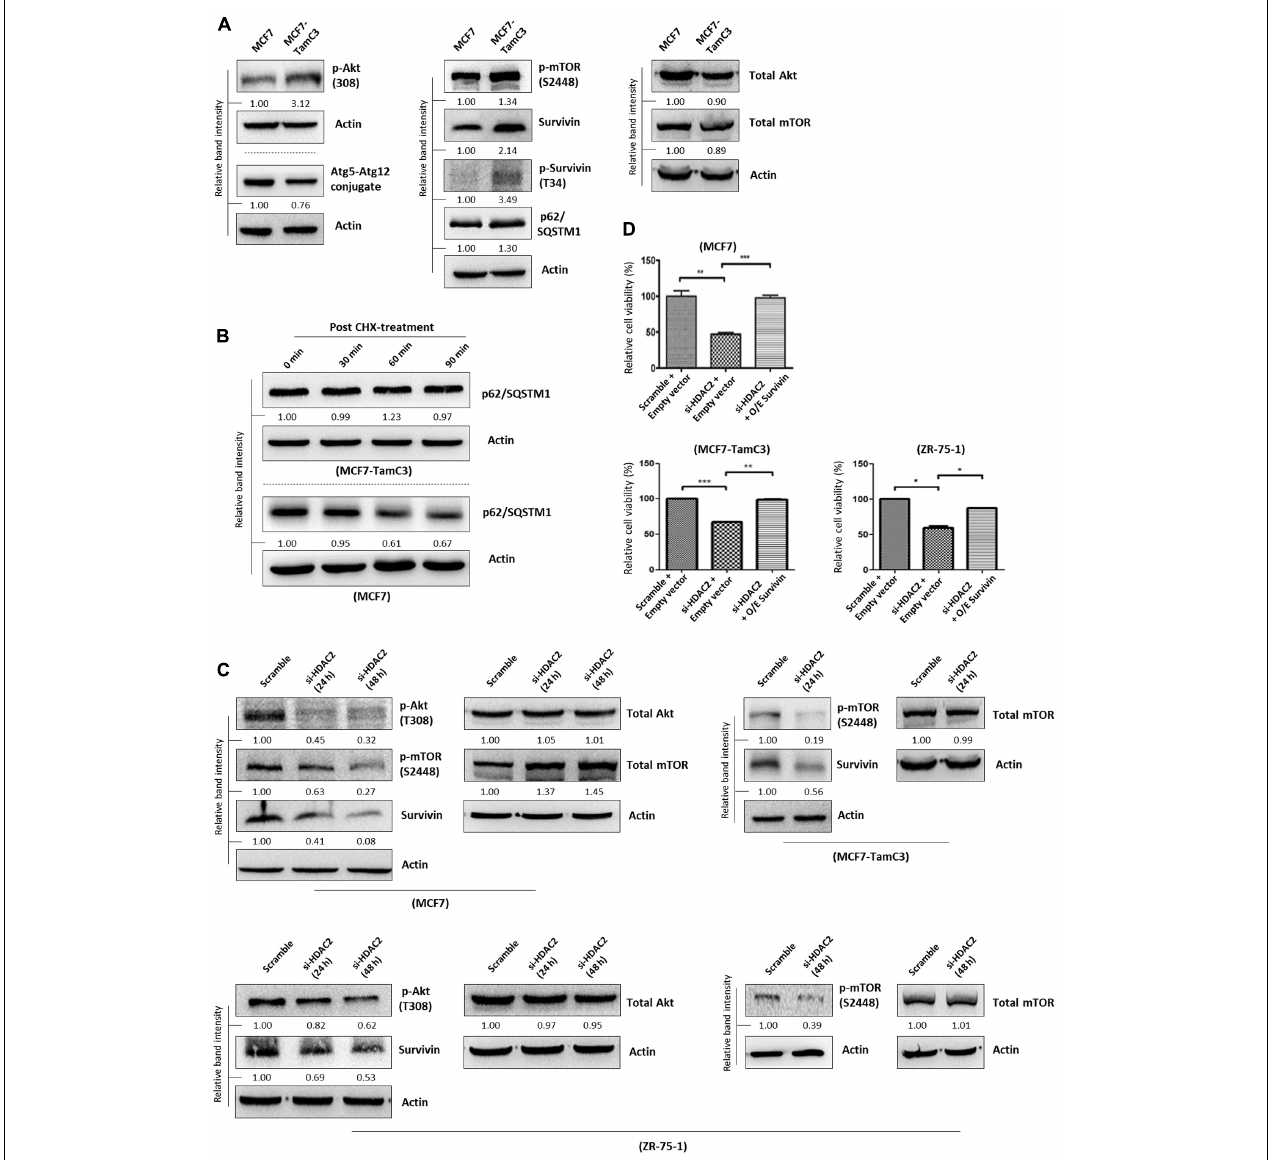
FIGURE 3 | HDAC2 positively regulates the expression of p-Akt, p-mTOR, and survivin in ER + breast cancer cells. (A) Expression of different proteins in MCF7 and MCF7-TamC3 cells was determined by Western blotting. (B) MCF7 and MCF7-TamC3 cells were treated with 10 µ g/mL cycloheximide (CHX) for 30 min to inhibit de novo protein synthesis. The expression of p62/SQSTM1 30 min, 60 min, and 90 min post-CHX treatment was determined by Western blotting. (C) Breast cancer cells were transfected with either scramble siRNA or HDAC2 siRNA for 24–48 h and expression of different proteins was determined by Western blotting. (D) MCF7, MCF7-TamC3, and ZR-75-1 cells were pre-transfected with either pCMV6-XL4 (empty plasmid) or pCMV6-XL4-survivin (O/E survivin) for 24 h and subsequently treated with or without HDAC2 siRNA for 96 h. Cell viability was assessed by the MTT assay. “ ∗ ” , “ ∗∗ ” , and “ ∗∗∗ ” denote a statistical significance ( P < 0.05, P < 0.01, and P < 0.001, respectively) between the testing